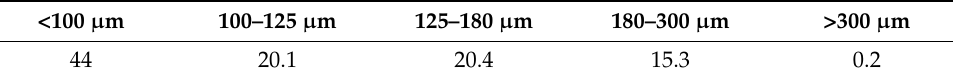
Table 3. Particle size distribution of SAP (wt%).